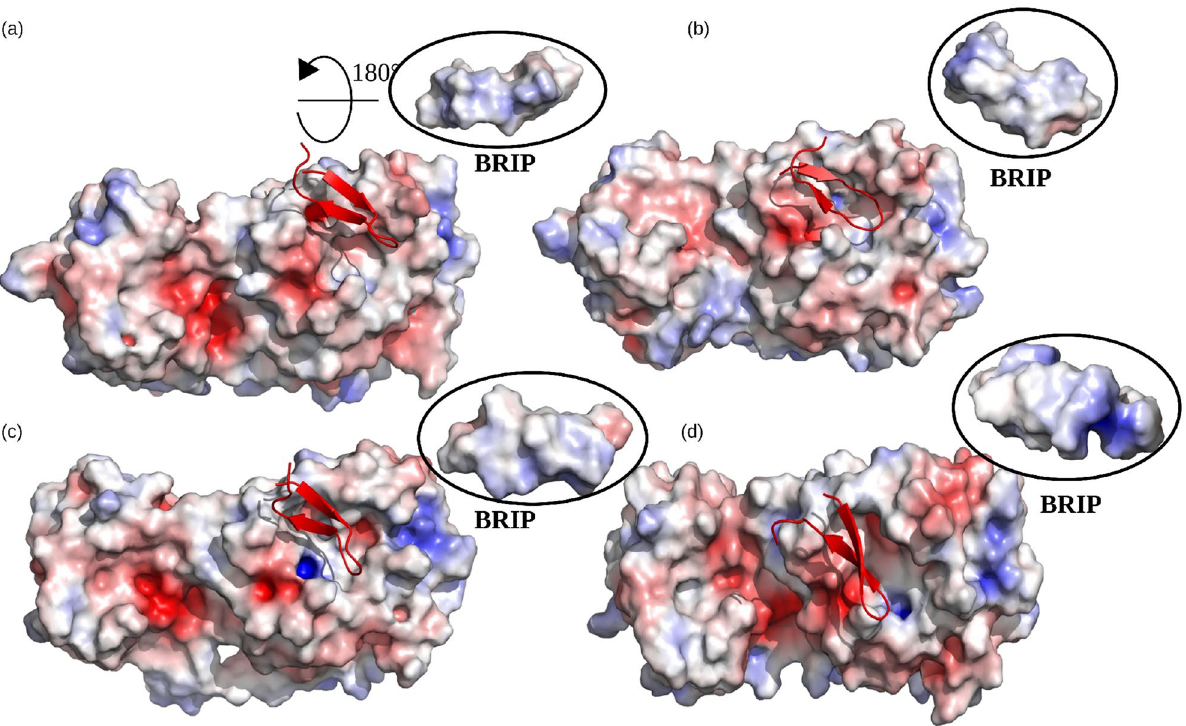
Figure 4. The net charge distribution on surface of M pro and BRIP at different time intervals during the